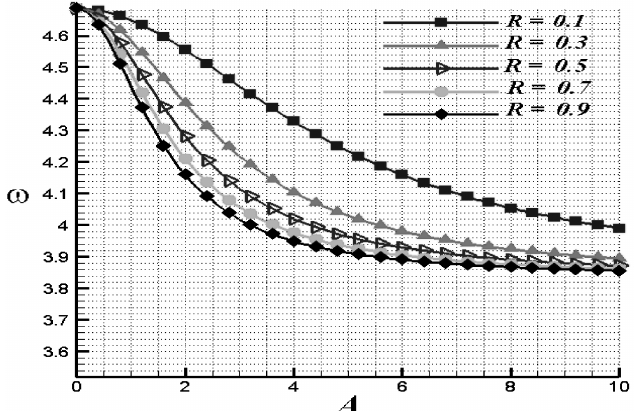
Fig. 5. Comparison of periods between two methods (case 2).